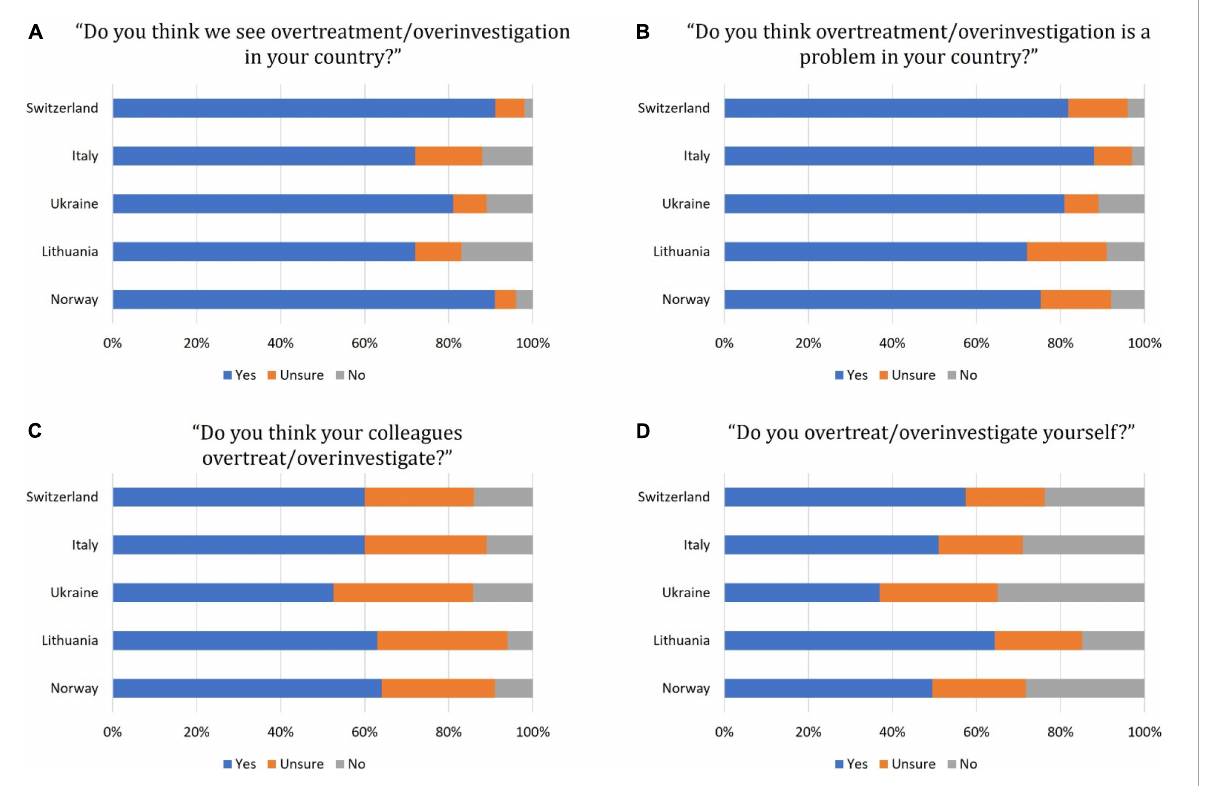
FIGURE2 Responses among different countries to the question “How much of medical practice in your country by your opinion is overtreatment/overinvestigation?”. A stacked bar chart represents responses in percentage on an incremental scale from 0 to 100% from one country all respondents.